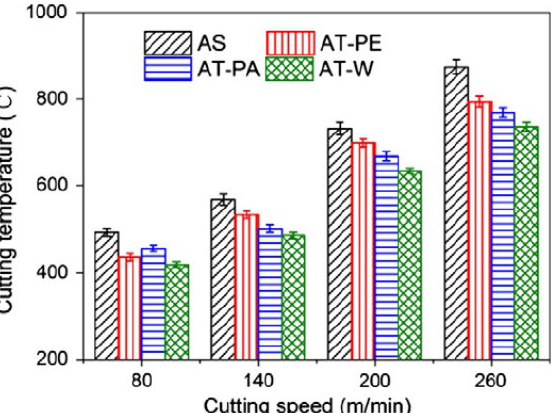
Figure 25. Cutting temperatures at the tool–chip interface of different tools at different cutting speeds ( a p = 0.2 mm, f = 0.2 mm/r) [74].